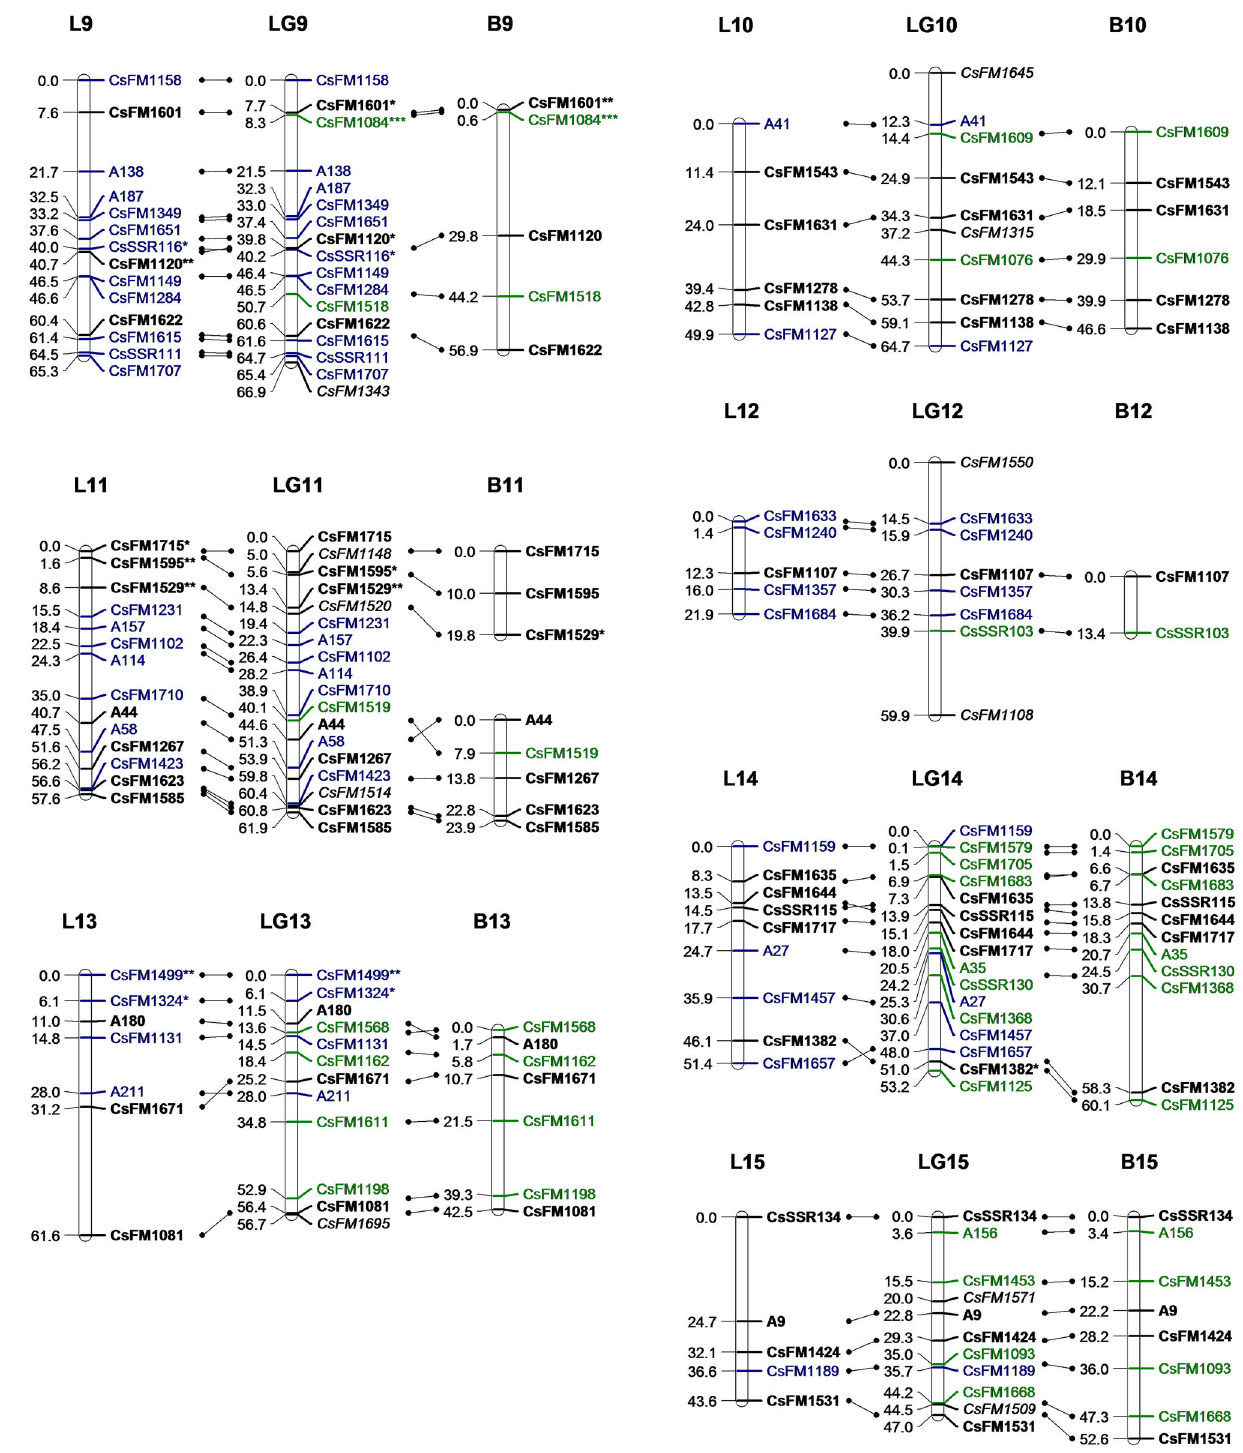
Figure 5. Linkage map based on SSR markers for C . sinensis (LG9-15). See legend of Figure 3.